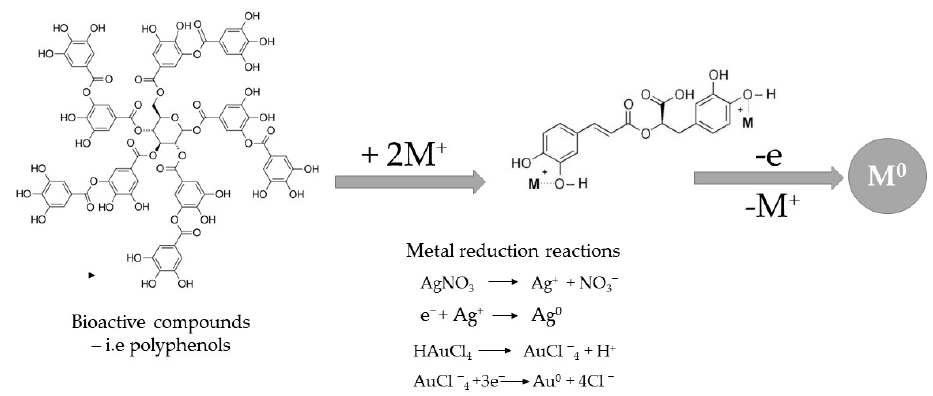
Figure 6. Proposed mechanism for obtaining metal nanoparticles via plant extracts.